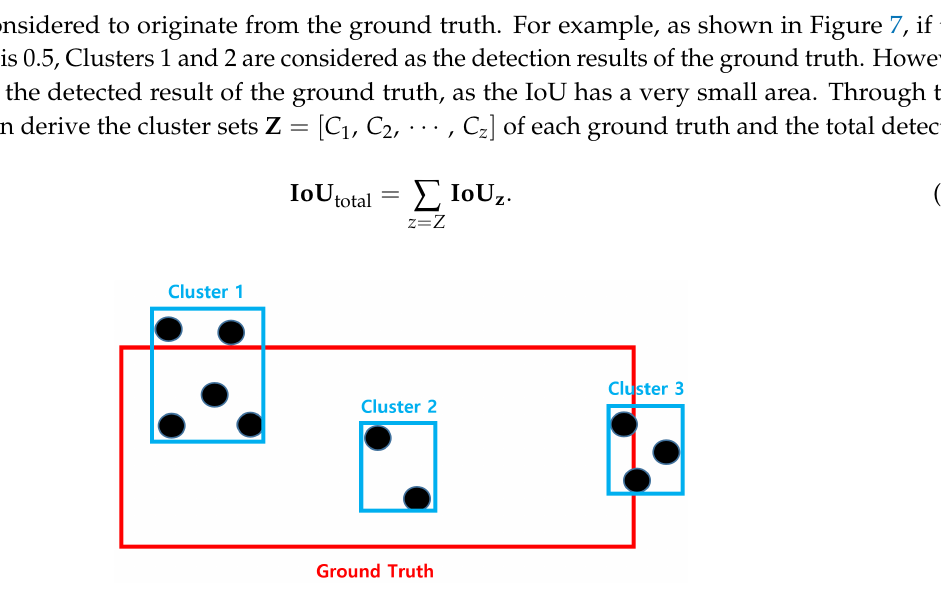
Figure 7. Example for measuring clustering